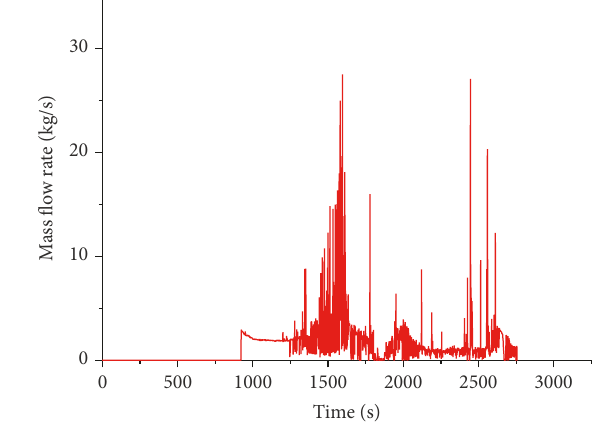
Figure 26: ADS-3 discharge flow rate.